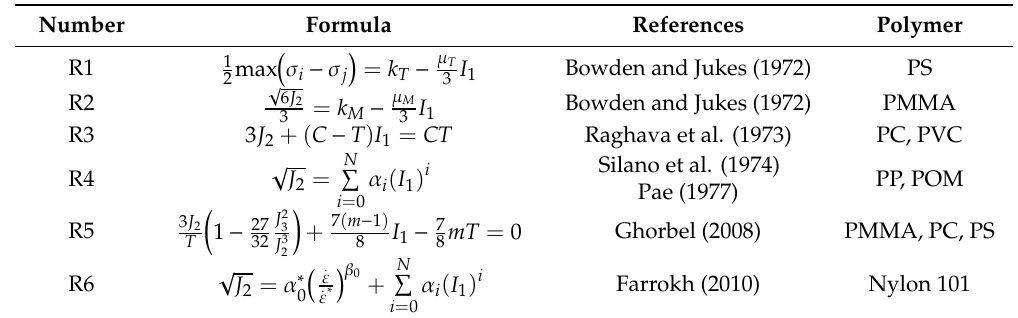
Table 1. Yield criterion